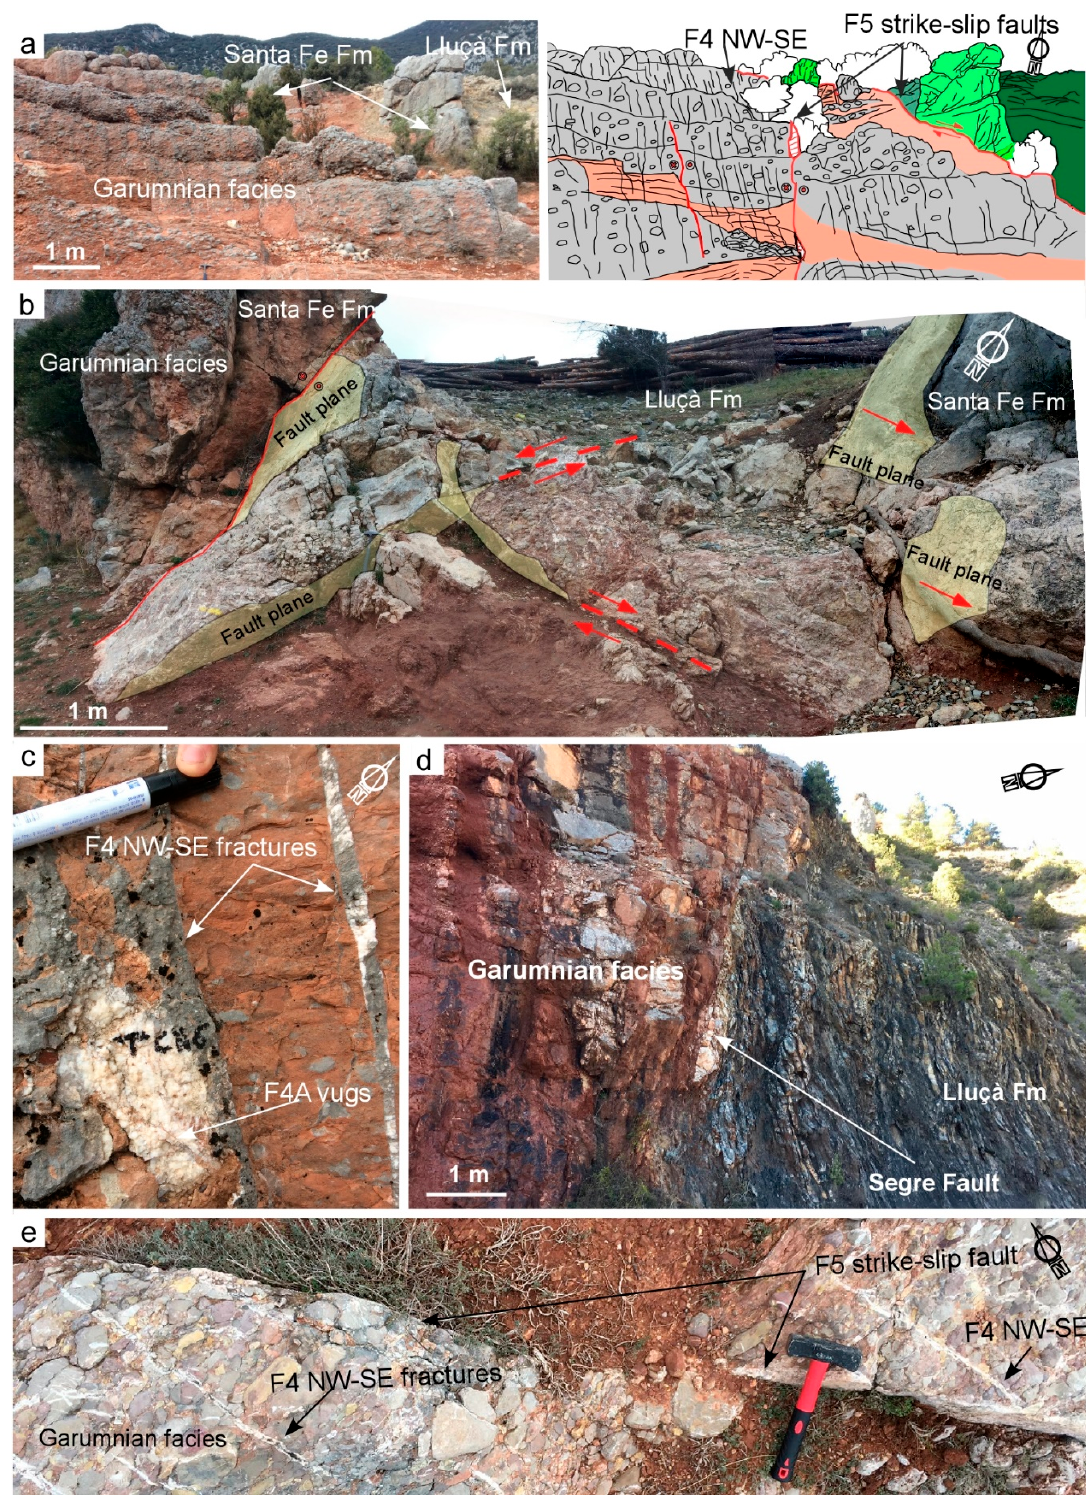
Figure 9. ( a ) Panoramic view and interpreted sketch of the studied formations. Note that the fracture density of F4 increases towards F5 and also the reactivation of some F4 fractures as F5 strike-slip faults. ( b ) Interpreted field view of F5 right-lateral and left-lateral strike-slip conjugate faults. ( c ) F4 fractures and associated vugs. ( d ) The Segre strike-slip fault juxtaposes the Lluçà Formation against Garumnian facies. ( e ) Crosscutting relationship between F4 fractures and F5 strike slip faults.